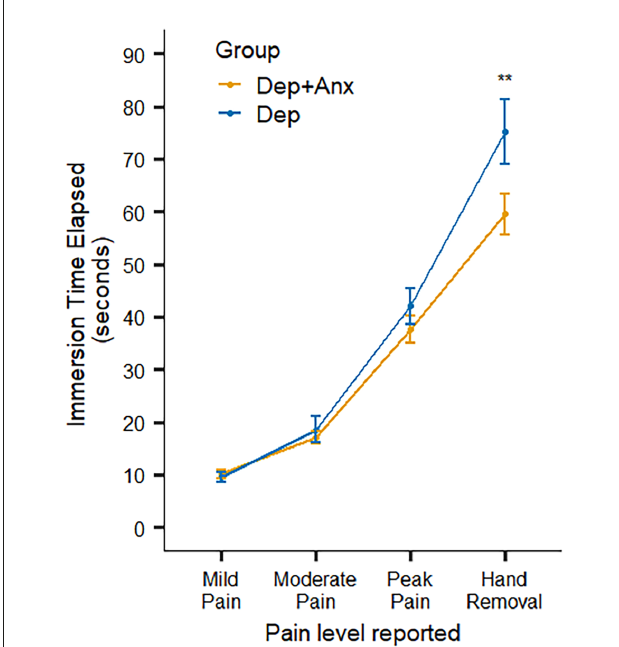
FIGURE2 Self-report ratings of pain and behavioral hand removal in the Cold-Pressor Task. Note that the Dep+Anx group removed their hand significantly more quickly than the Dep group. Error bars represent ± 1 SE of the mean. Dep+Anx, comorbid depression and anxiety disorders; Dep, depression only. ** p < 0.01.